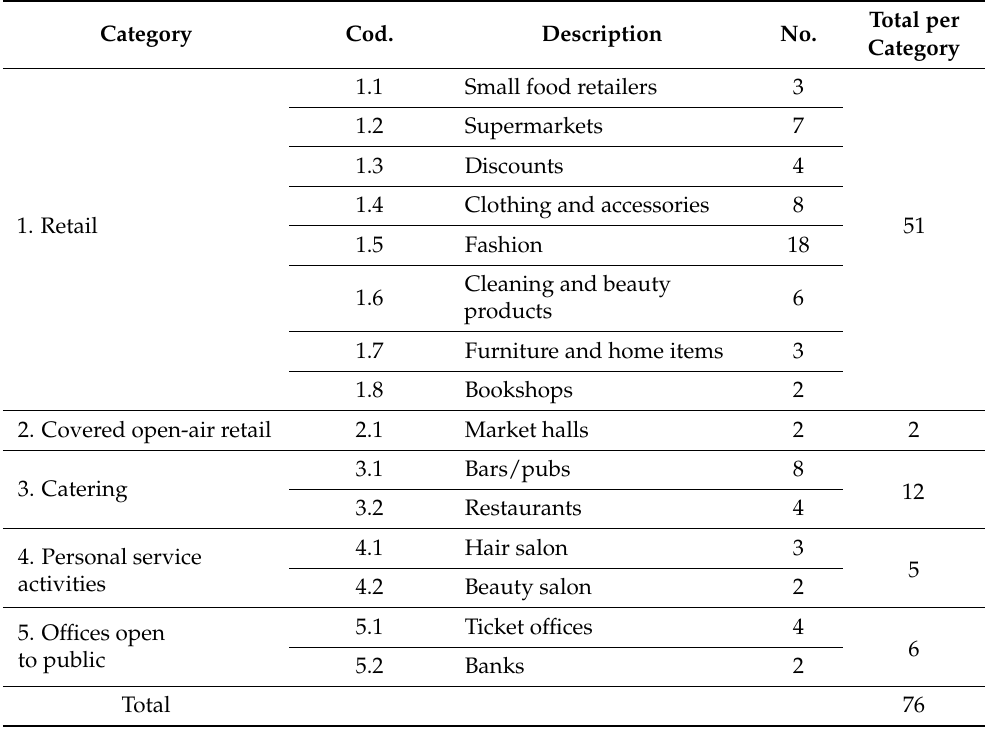
Table 1. Facilities investigated in the field